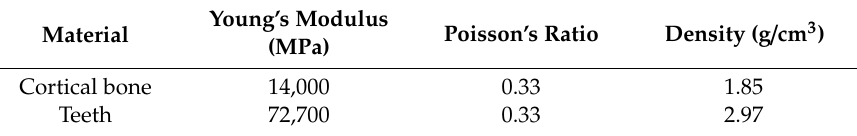
Table 1. Mechanical properties assigned to the analyzed materials [18,19].